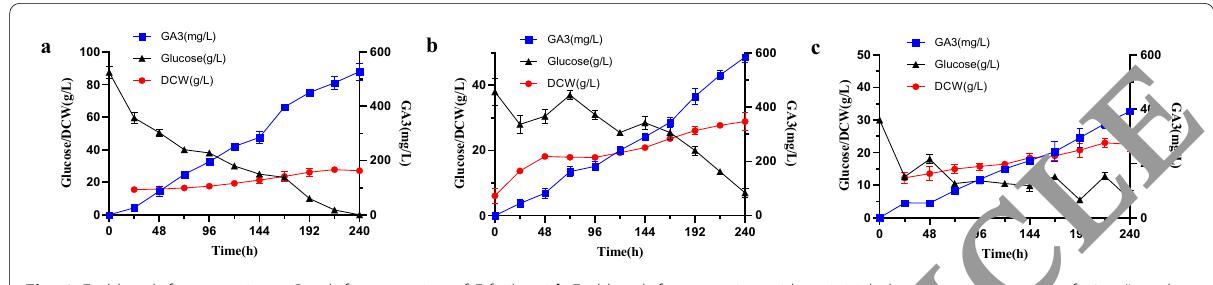
Fig. 6 Fed‑batch fermentation. a Batch fermentation of F. fujikuroi . b Fed‑batch fermentation with an initial glucose concentration of 40 g /L and residual glucose controlled at 30–40 g/L. c Fed‑batch fermentation with an initial glucose concentration of 30 g /L and residual glucose controlled at 10–20